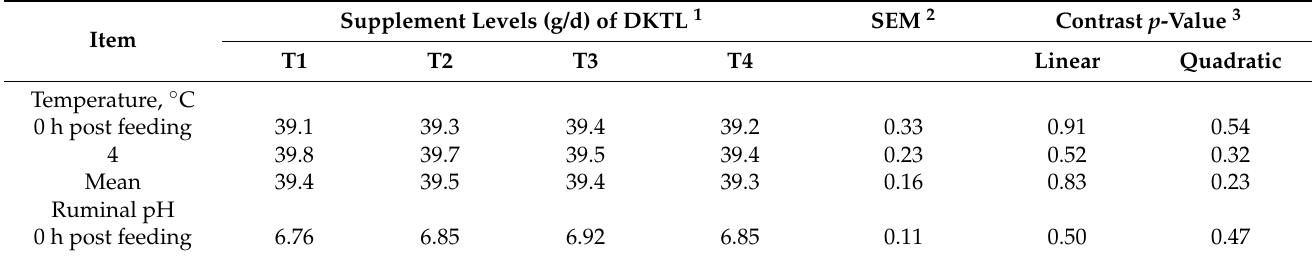
Table 5. Effects of supplement levels (g/d) of dried kratom leaves on rumen fermentation and blood metabolites in